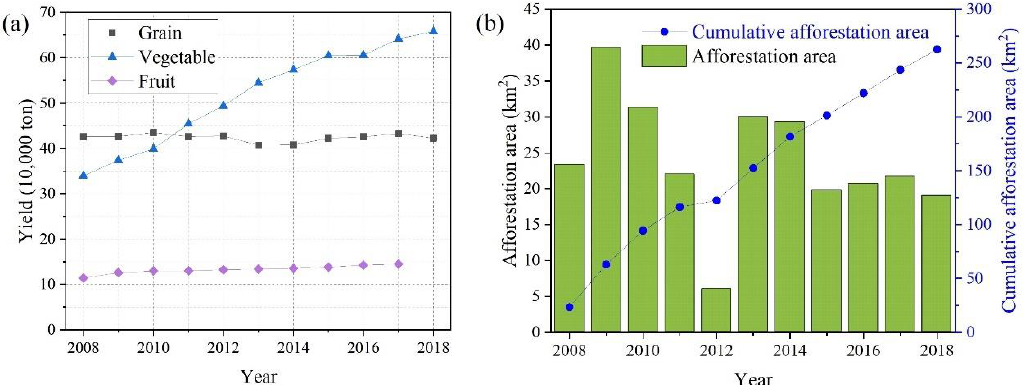
Figure 8. ( a ) The annual yield of grain, vegetable and fruit during 2008–2018; ( b ) the annual afforestation area and the cumulative afforestation area during 2008–2018 (source: [33] ).